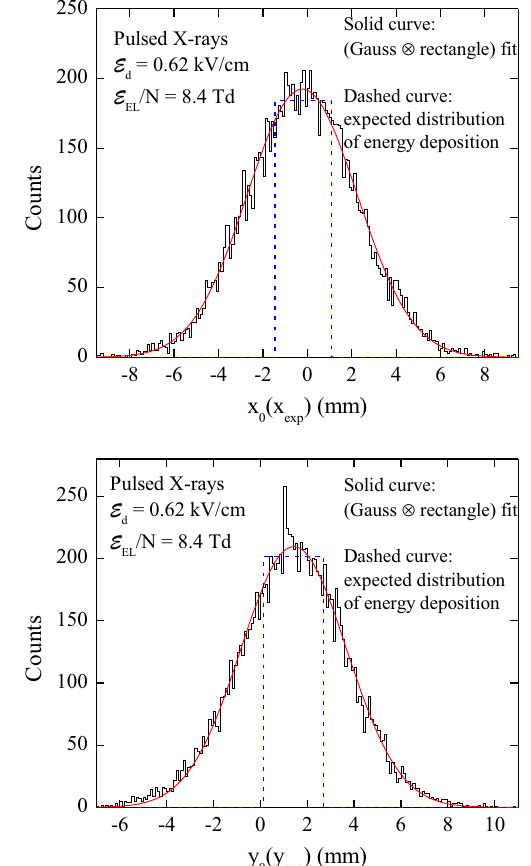
Fig. 20 Direct SiPM-matrix readout: projections of the 2D distribu- tion presented in Fig. 19 on x and y axes. Also shown are the fit of the x 0 ( x exp ) and y 0 ( y exp ) distributions (red curves) and the expected dis- tributions of the true coordinates of the interaction region (blue dotted curves), defined by the positions of the X-ray tube and collimator and by the X-ray range in liquid Ar. Note that here the signal is produced by several X-ray photons in a pulse, with the average energy of 25 keV, absorbed in a thin (3 mm) liquid Ar layer near the cathode